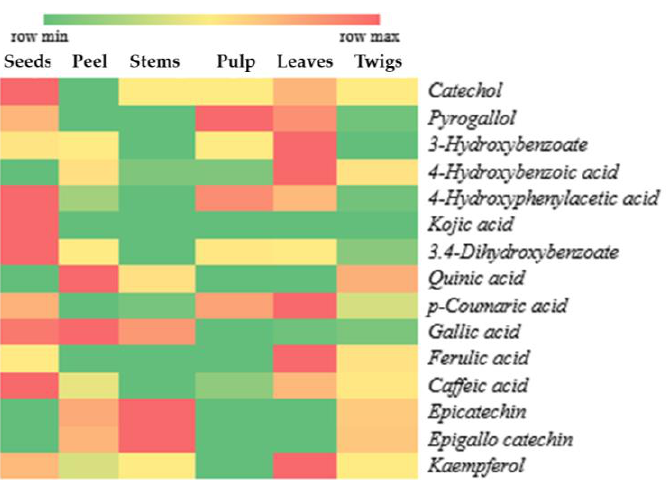
the intensity of green color shows indicates low compound content.